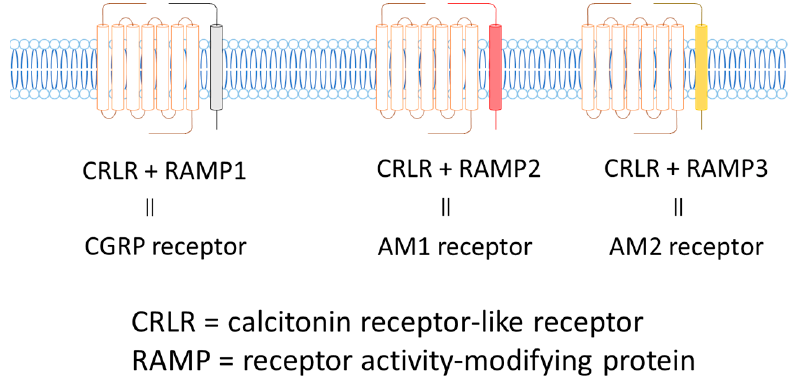
Figure 3. CGRP and AM Receptors.